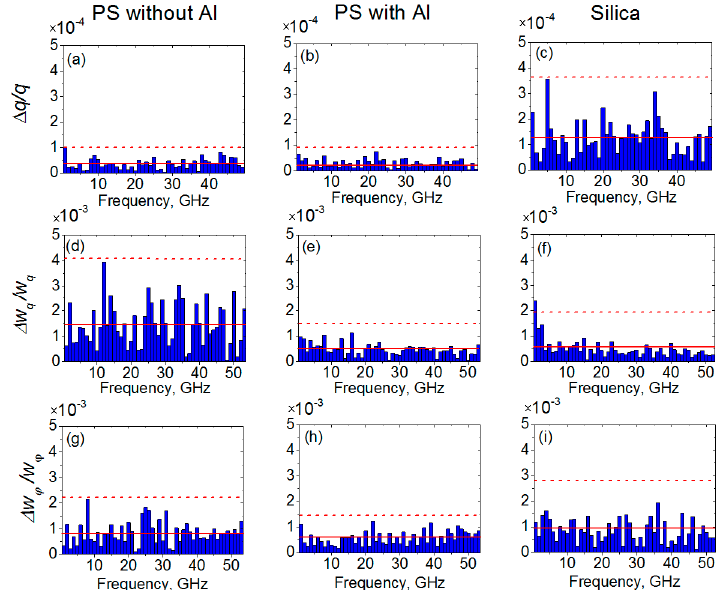
Figure 8. Fourier spectra from the distance between the two opposite Bragg peaks Δ q ( τ )/ q ( a – c ) and Bragg peaks widths in radial Δ w q ( τ )/ w q ( d – f ) and azimuthal Δ w φ ( τ )/ w φ ( g – i ) directions for three selected samples. Fourier spectra calculated from the results of diffraction pattern analysis shown in Figure 7. Average value of all Fourier components is indicated by the red line. The dashed red line corresponds to the 3 σ level above the average value, where σ is the standard deviation and is determined from the distribution of Fourier components.